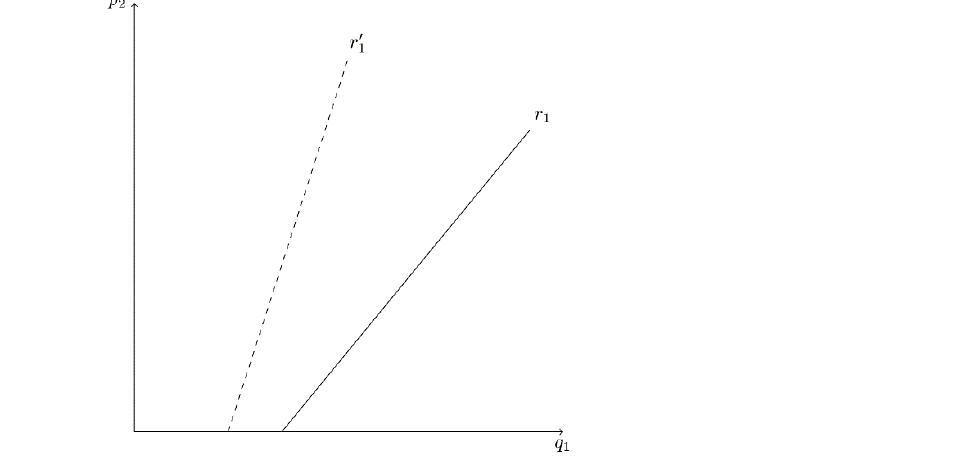
Figure 13. Firm 1’s Best-Reply Curve in the Cournot-Bertrand Model When CEO 2 Underestimates Product Substitutability.